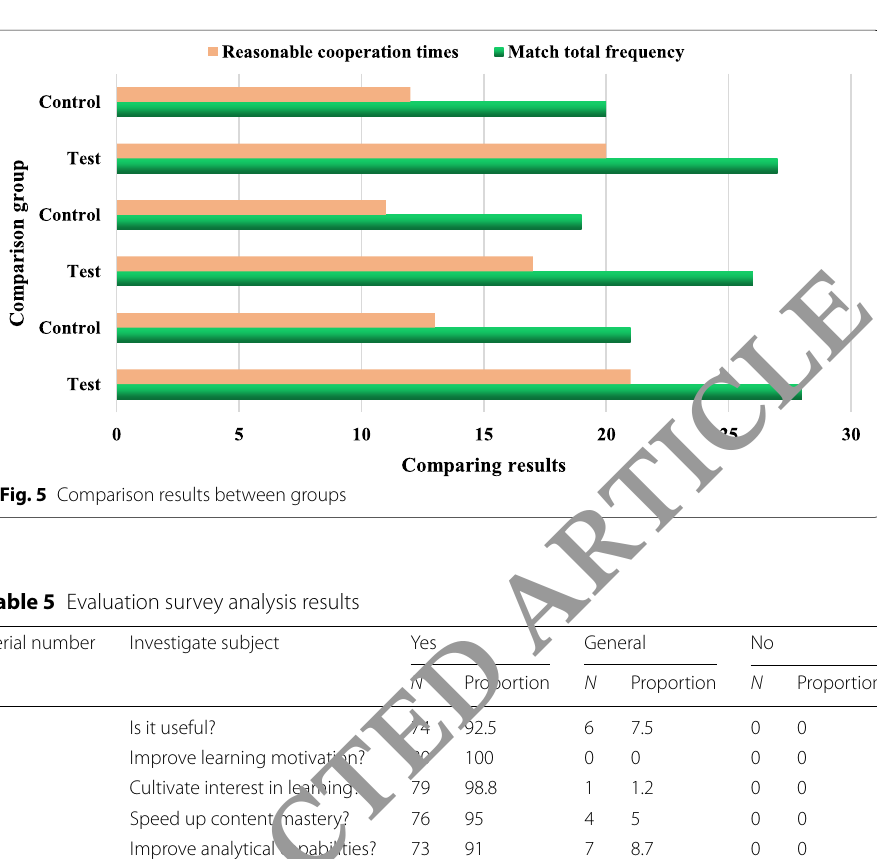
Table 5 Evaluation survey analysis